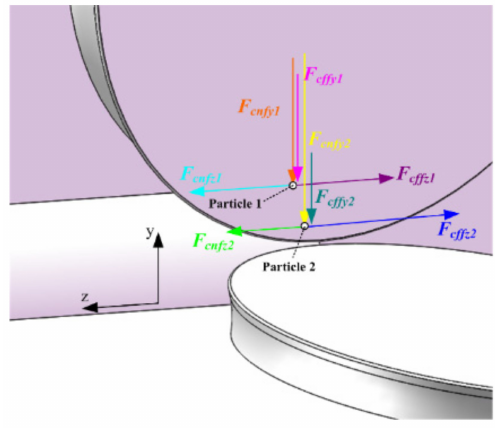
Figure 3. Force analysis of